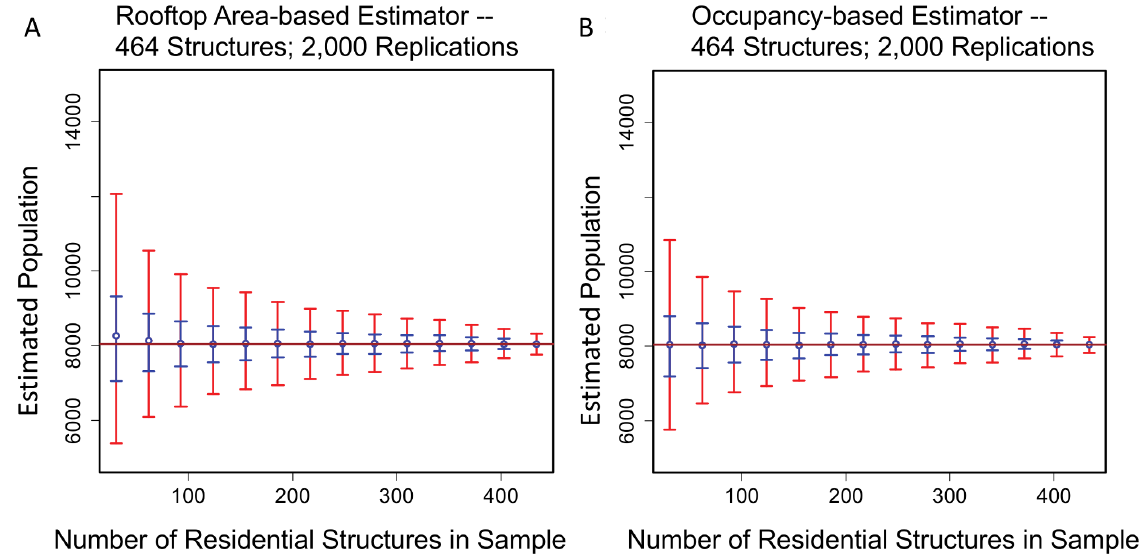
Figure 5. A comparison of occupancy-based and rooftop area-based bootstrap population estimators. (A) Occupancy-based population estimations and (B) rooftop area-based population estimations with 0.50 CIs (blue) and 0.95 CIs (red). There are 464 residences ( DS02 ) and 2,000 bootstrap replications per sample. The confidence intervals (CIs) were calculated using bootstrap percentiles.